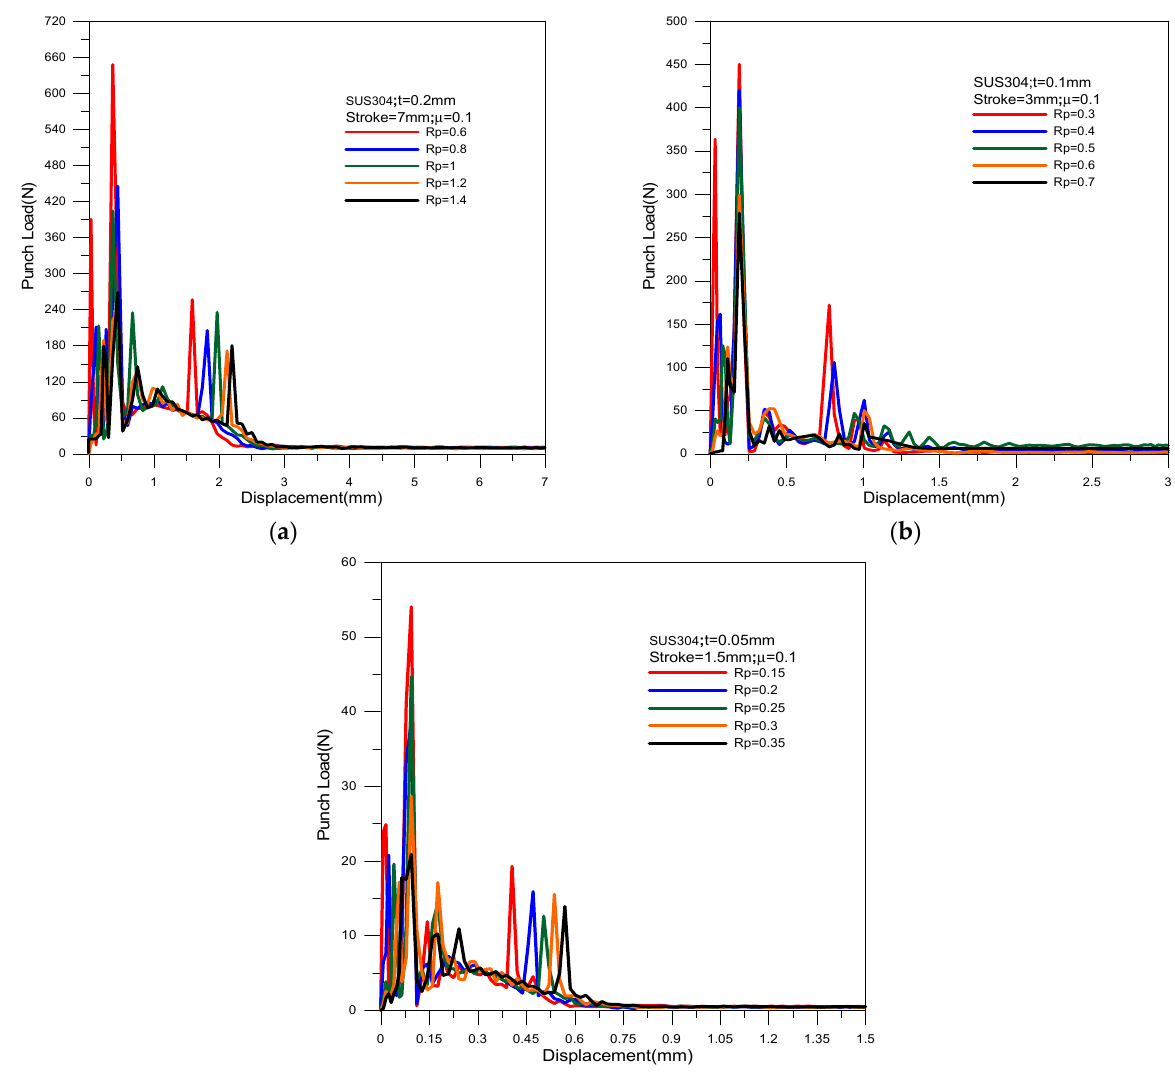
Figure 10. The relationship between the load and stroke of the punch with different R p : ( a ) Model 1; ( b ) Model 2; ( c ) Model